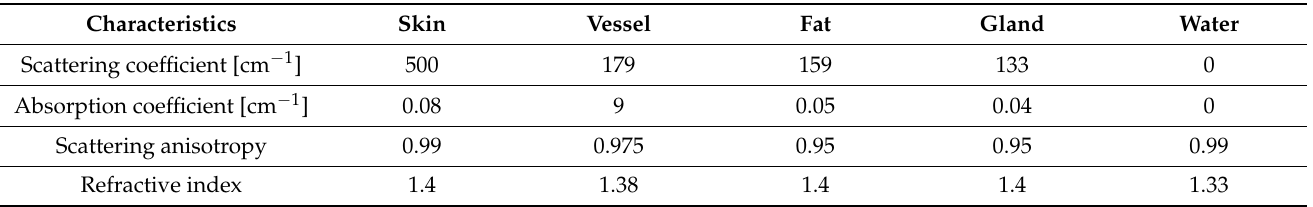
Table 3. Optical parameters used for simulation of light propagation for initial pressure distribution via photoacoustic effect